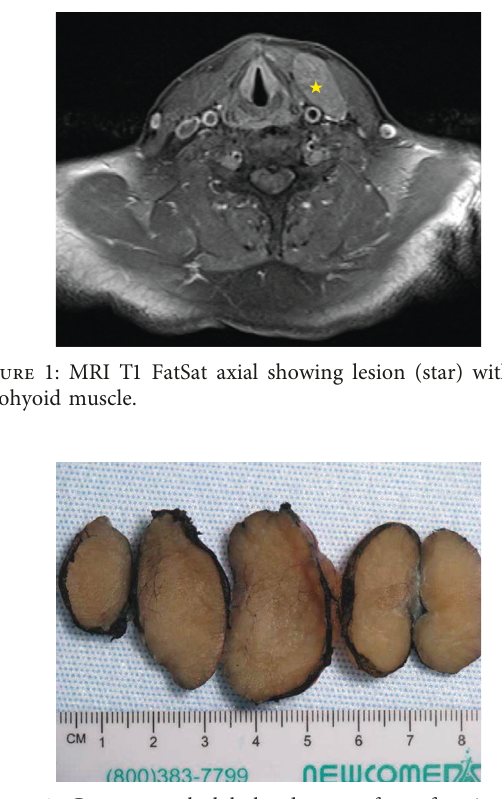
Figure 2: Gross coarsely lobulated cut surface of excised rhab- domyoma. Note: mass appears discolored due to formalin fixation.